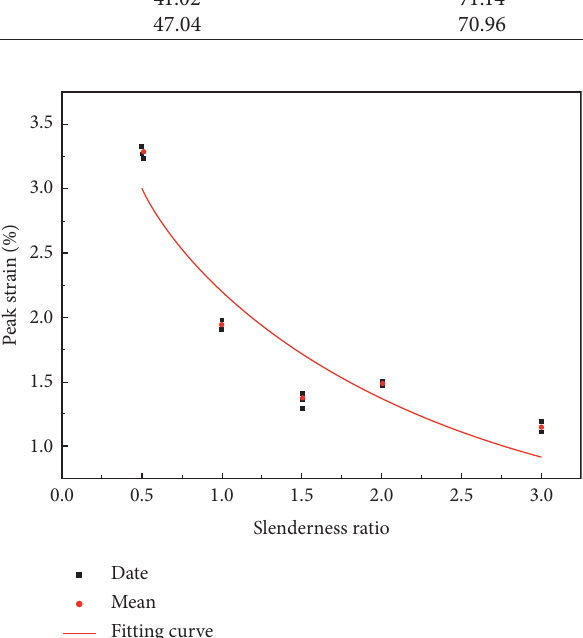
Figure 3: The peak strength versus the slenderness ratio ( D ).